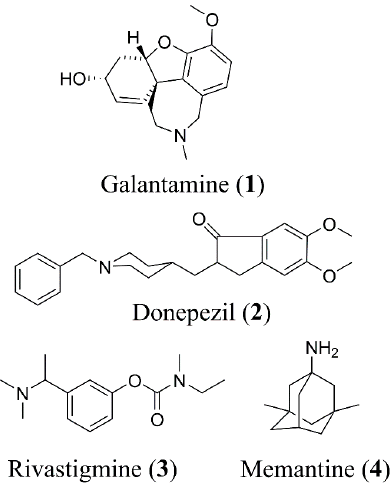
Figure 1. Structures of currently approved Alzheimer’s disease (AD) drugs galantamine ( 1 ), donepezil ( 2 ), rivastigmine ( 3 ) and memantine ( 4 ).